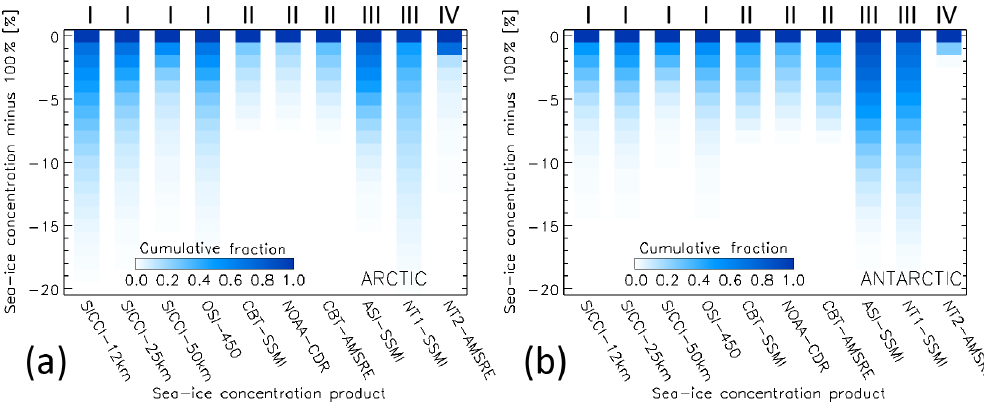
Figure 13. Cumulative distribution of the SIC difference to 100% at the near-100% reference SIC locations for all 10 algorithms based on data of the years 2007 through 2011 for (a) the Arctic and (b) the Antarctic. Roman numbers at the top denote product groups (see Table